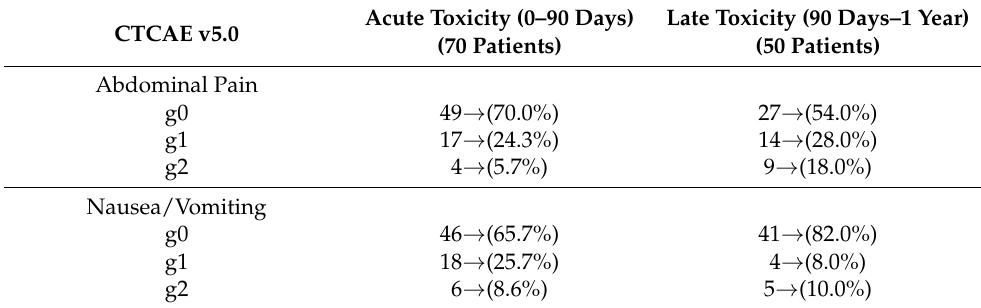
Table 4. SMART-related acute and late toxicities. CTCAE v5.0